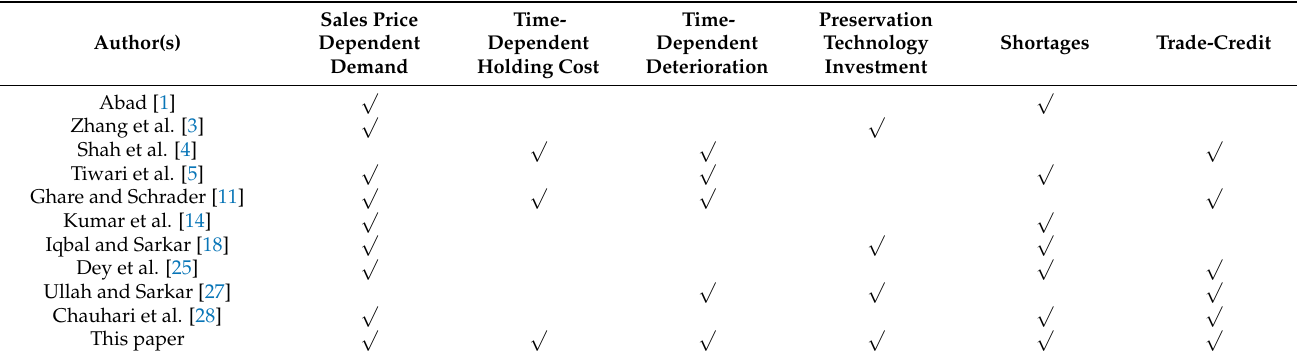
Table 1. Summary of the influence of the dissimilar